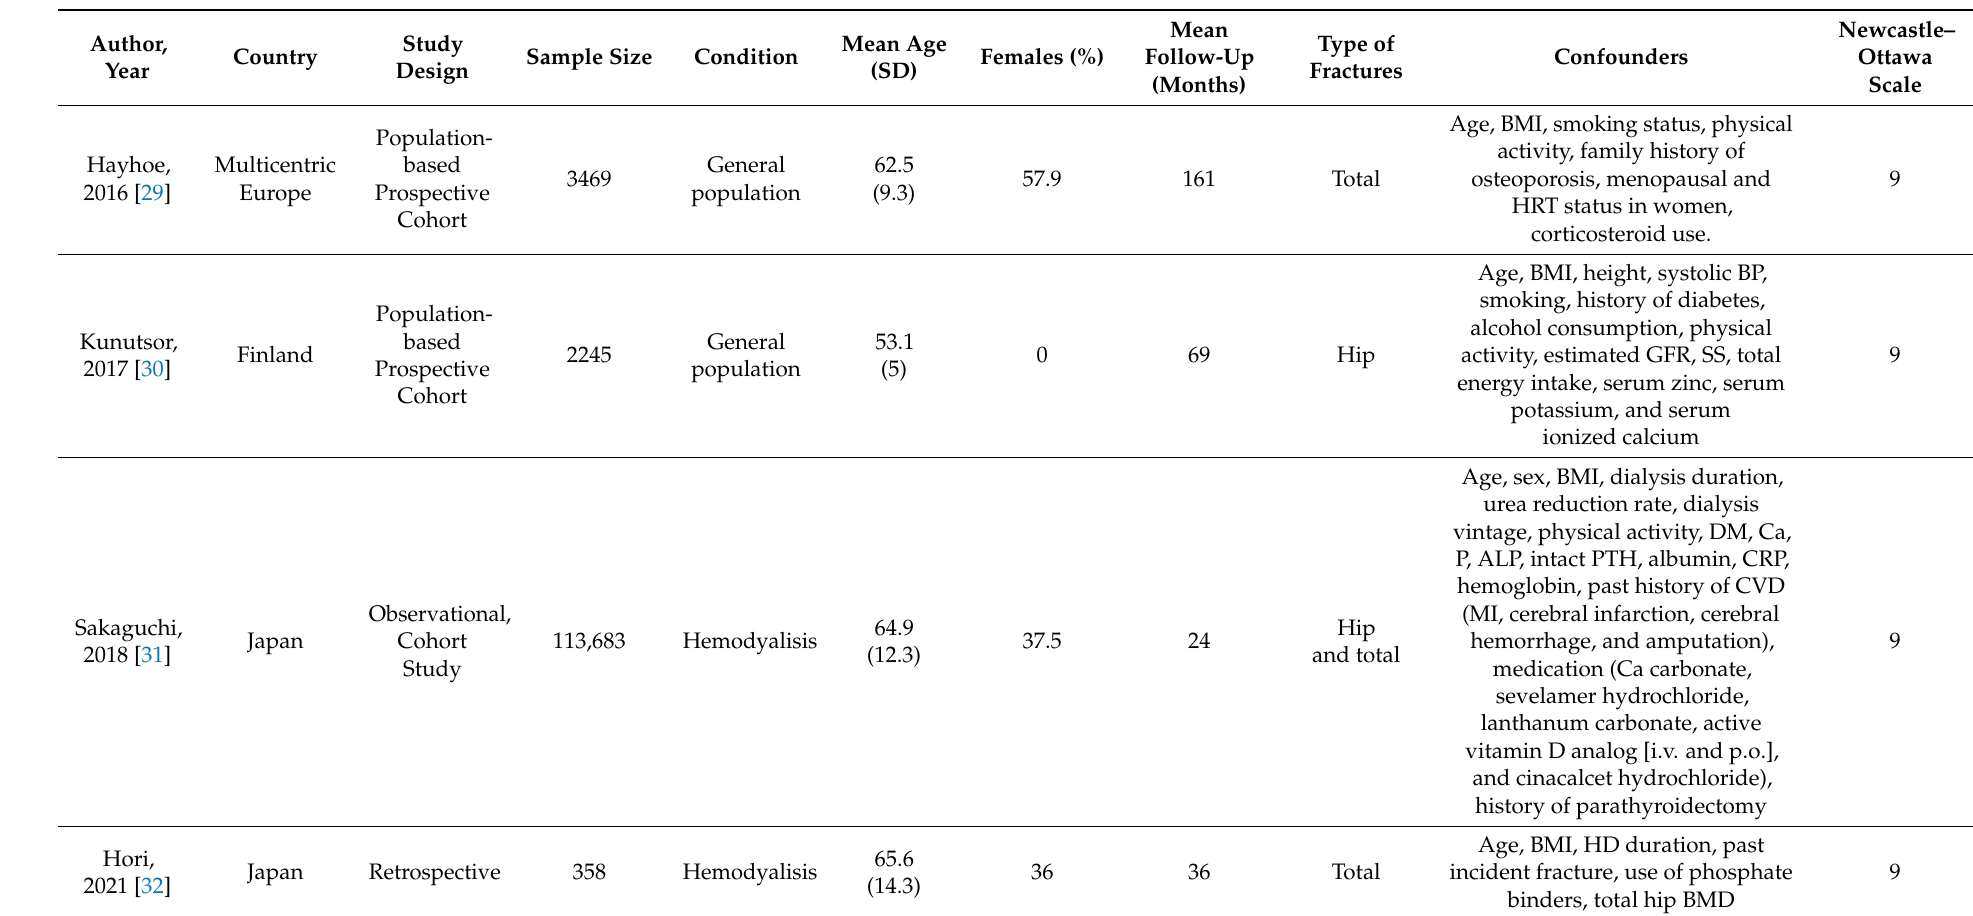
Table 1. Descriptive findings of the studies